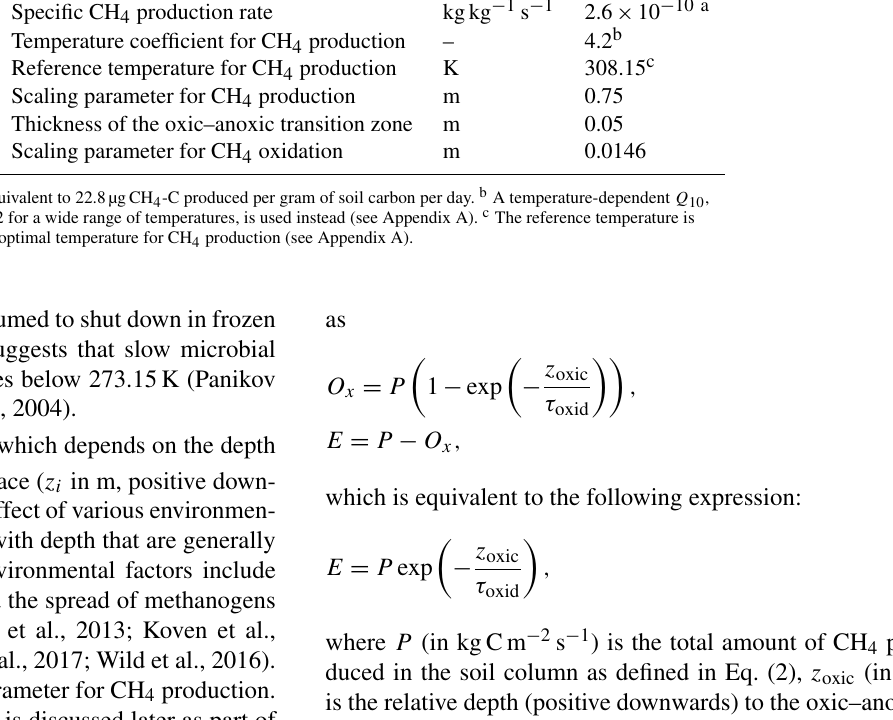
Table 1. Model parameters for methane production and oxidation.